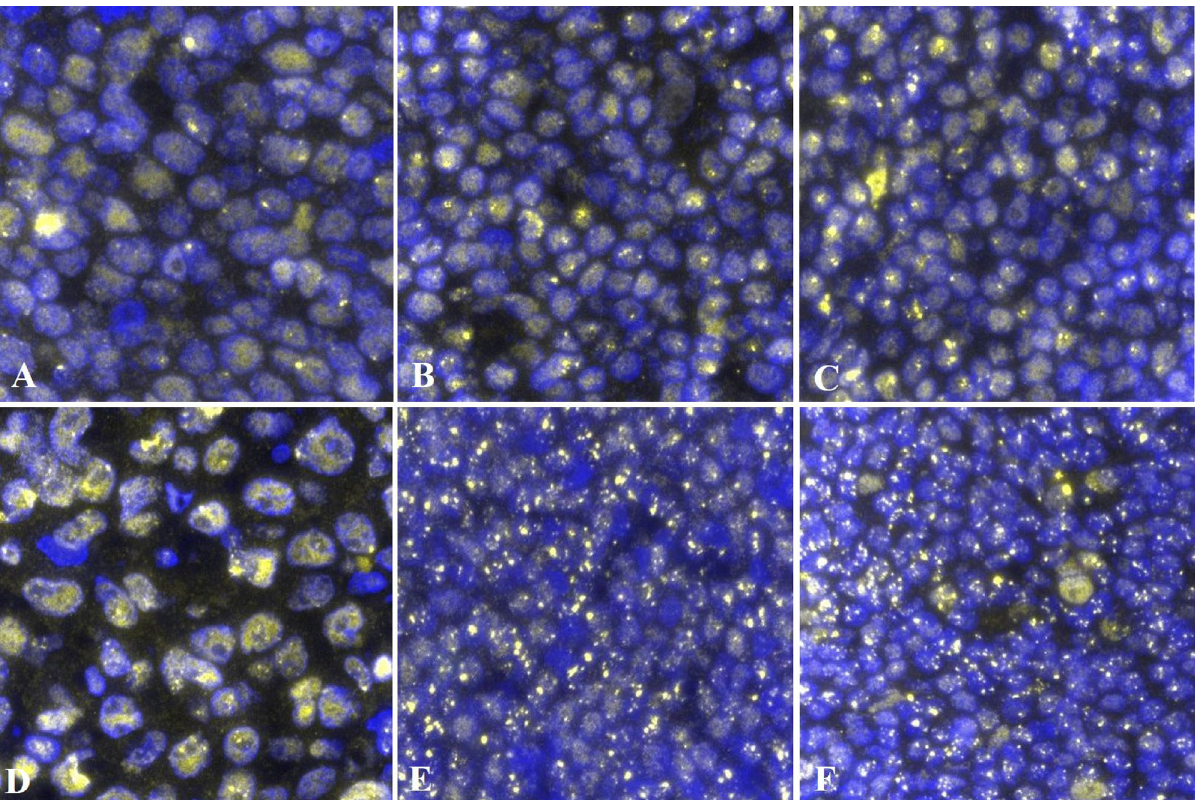
Figure 2. Representative images of 53BP1 expression in benign and malignant lymphoid proliferative lesions. (A) Germinal center; (B) mantle-marginal zone; (C) primary follicle; (D) diffuse large B-cell lymphoma; (E) mantle cell lymphoma, classical type; and (F) follicular lymphoma grade 1. Numerous abnormal types of 53BP1 expression are shown in both (E) and (F) . The images were captured after identifying anatomical structures with BCl2 and FDC expression as shown in Supplementary Fig. 1. Images for 53BP1 expression were photographed with the Z-stack function of Biorevo BZ-X710 microscope (Keyence Japan, Osaka, Japan), and their signals were measured using the image analysis software provided with the Biorevo